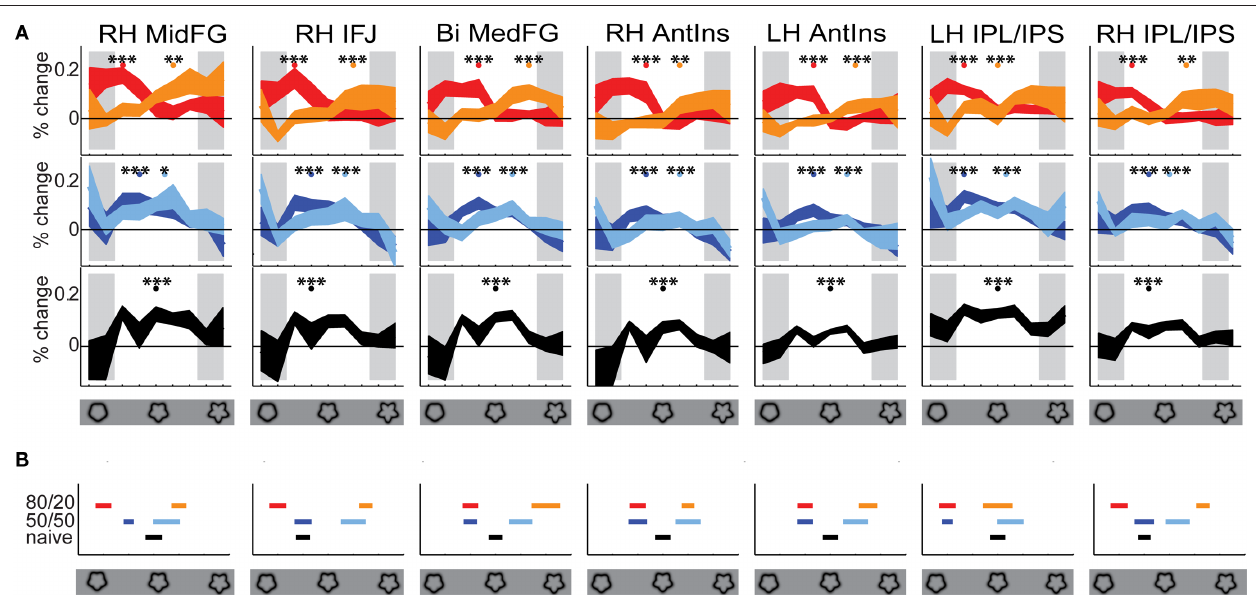
Figure 6 | Frontal and parietal selectivity at 80/20 for contraindicated shapes is persistent at 50/50. (A) Colors and x -axis are as in Figure 3 . Curvature levels were binned into 9 bins; the curves show mean within-ROI fMRI signal level vs. baseline at each bin. Shading indicates ± 1 SE across subjects. Gray shading indicates bins in which the targets were not ambiguous. Colored dots above the curves show the median curvature level, across subjects, of the maximum fMRI response within the ambiguous portion of the stimulus set. Stars indicate significance levels of the difference between the activity at these levels vs. the mean activity level across all ambiguous bins,